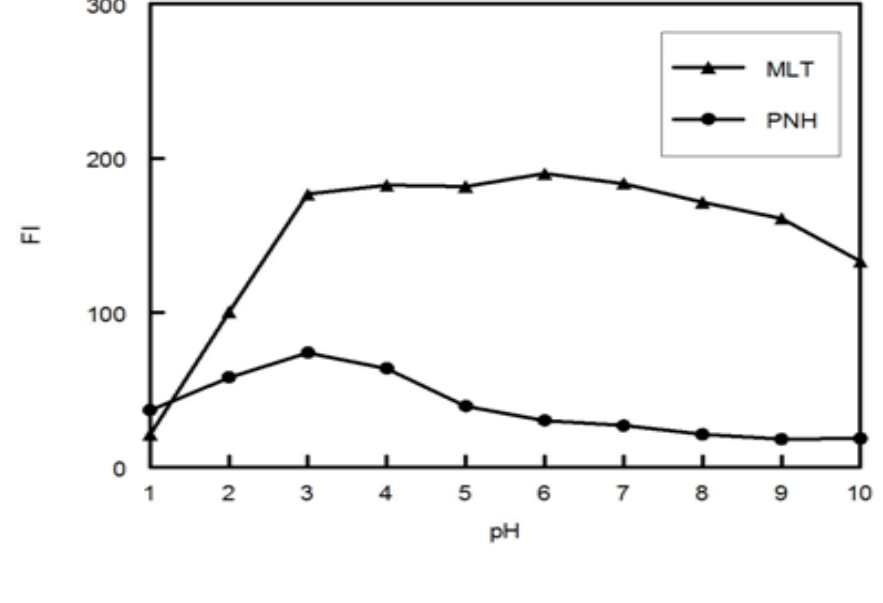
Figure 3. Effect of pH on FI of MLT and PNH (100 ng mL − 1